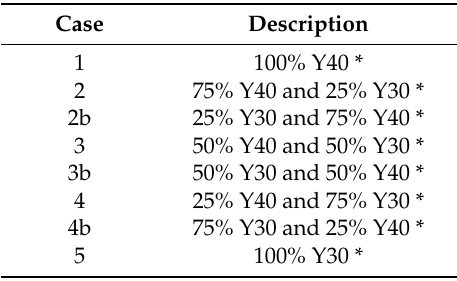
Table 2. The different cases for simulation of divided magnets. Star * indicates the magnet closest to the stator.